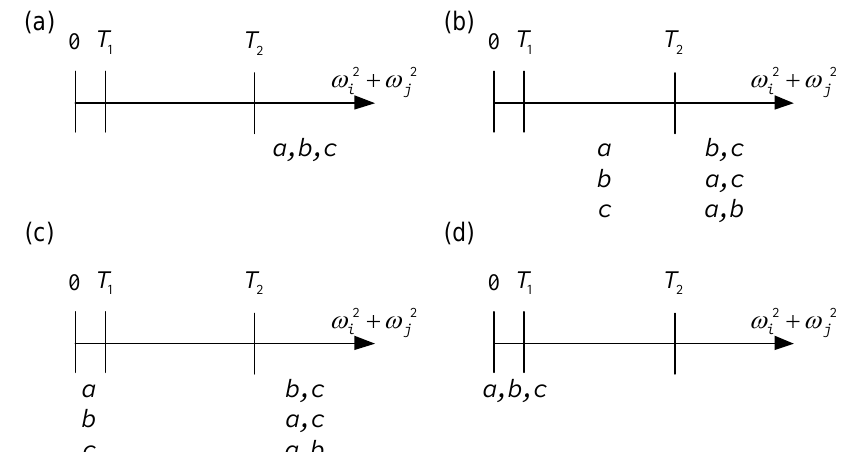
Figure 5. Four different scenarios which utilize different